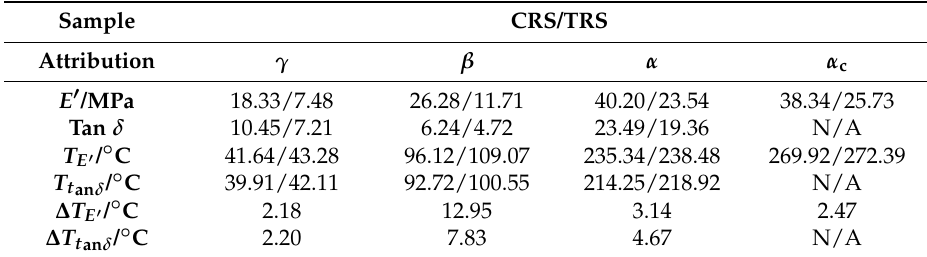
Table 2. The experimental parameters of degummed Chinese (CRS) and Thailand (TRS) B. Mori silk